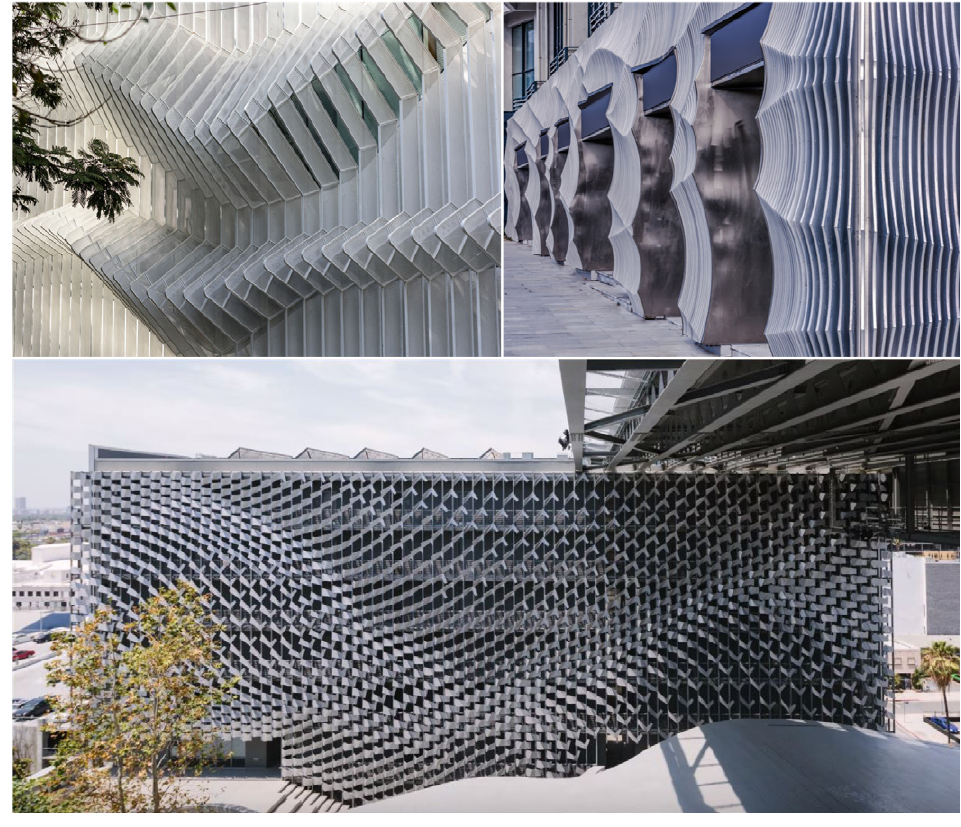
Figure 1. Examples of parametric architecture (ArchDaily,